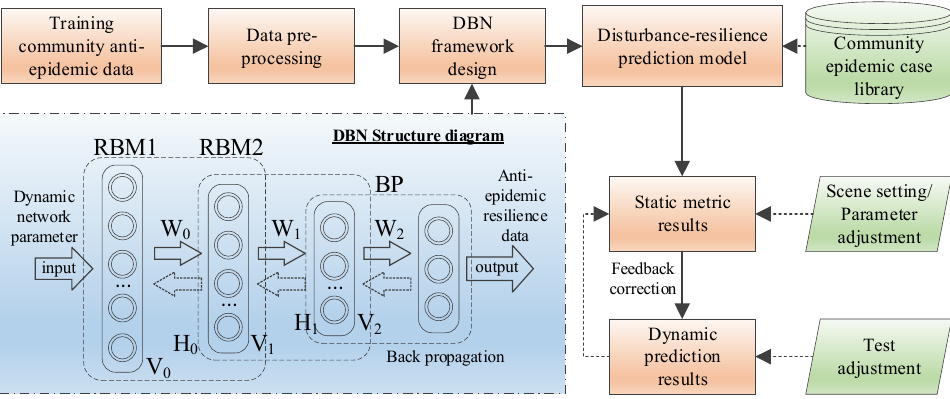
Figure 4. Forecast flow chart of community anti-epidemic resilience.